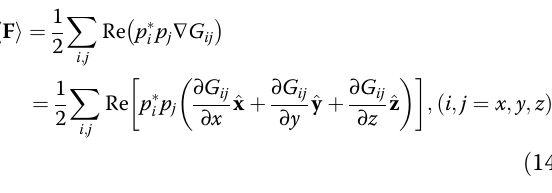
ffiffiffiffiffiffiffiffi p n o 1 (cid:2) k 2 tr d k tr ð 17 Þ = 12 πε 3 is the 0 c